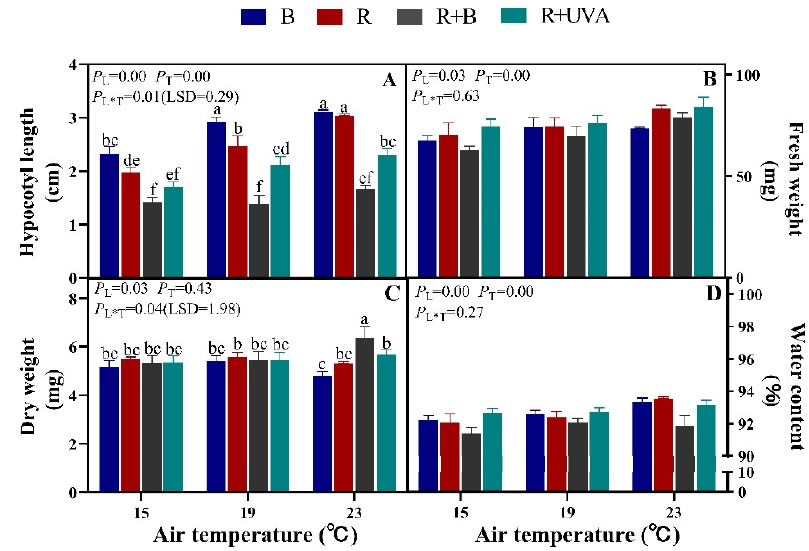
Figure 3. Hypocotyl length ( A ), fresh weight ( B ), dry weight ( C ), and water content ( D ) of broccoli sprouts grown for 5 d under different light [blue (B), red (R), mixture of R and B (R+B), as well as mixture of R and UVA (R+UVA)] and air temperature (15, 19, and 23 °C) regimes. Error bars indicate SEM (n = 3, each replicate representing the mean of five petri dishes). Different letters show statistically significant differences between treatments ( p < 0.05) as established by the l.s.d.